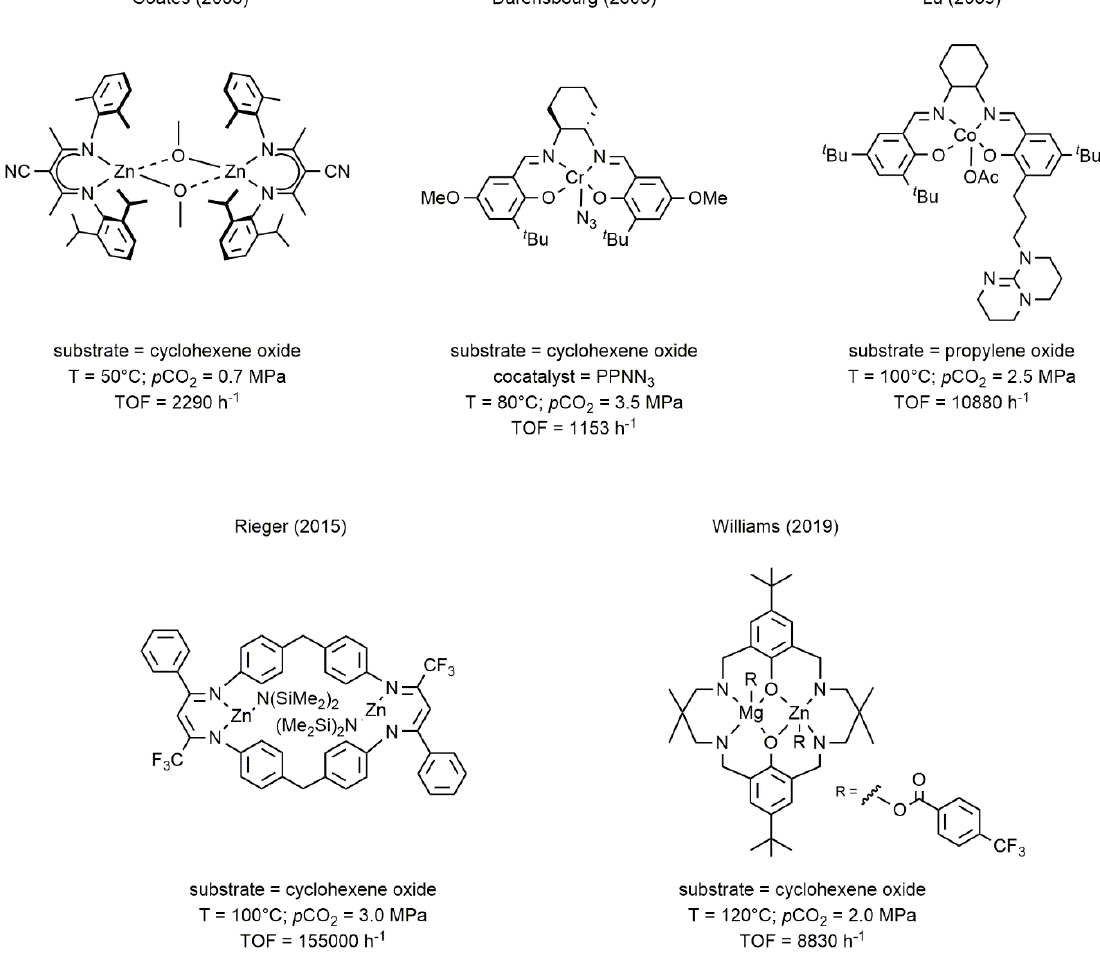
Figure 2. Representative catalytic systems for the synthesis of aliphatic polycarbonates (APC) from CO 2 and epoxides [33–37].